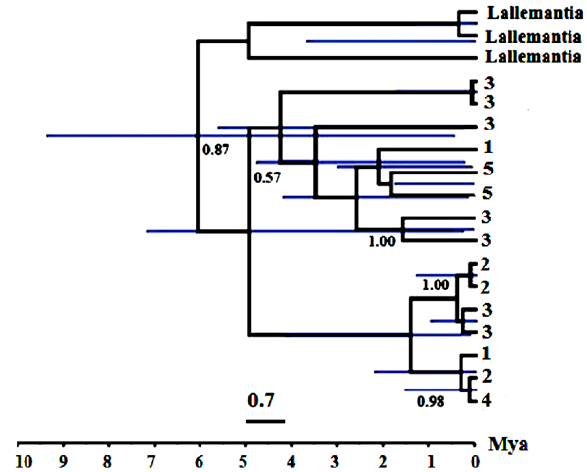
Figure 6. Chronogram from BEAST analysis of the studied prov- inces for Ziziphora clinopodioides based on the cp-DNA dataset ( rpL16 ), showing 95% highest posterior density bars (HPD) in pur- ple. Numbers on nodes are clade credibility values. (Provinces 1-5 are: 1- Qazvin, 2- Razavi Khorasan, 3- Mazandaran, 4- Tehran, and 5-